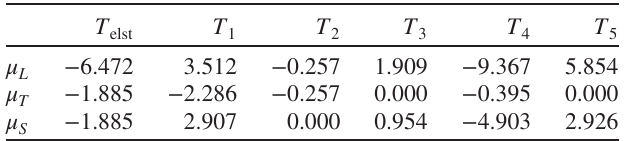
TABLE IV. Contribution to the Ar flexoelectric coefficients (in pC/m) from the different terms of Eqs. (72) and